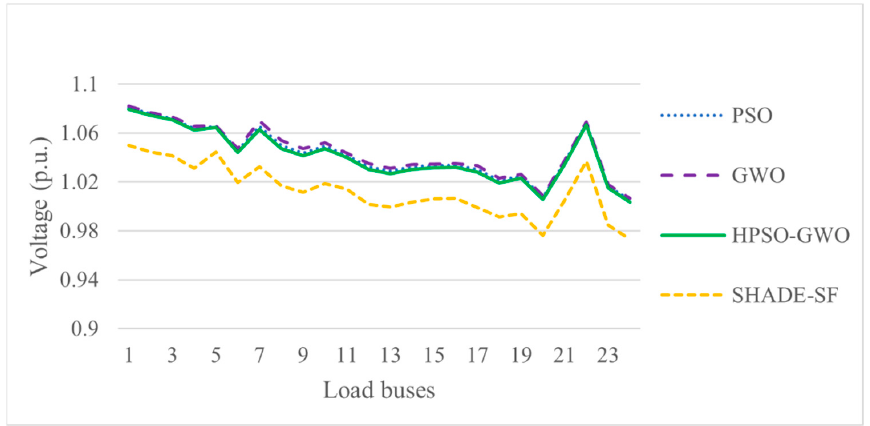
Figure 23. Load buses voltage profile comparison (Case 4).